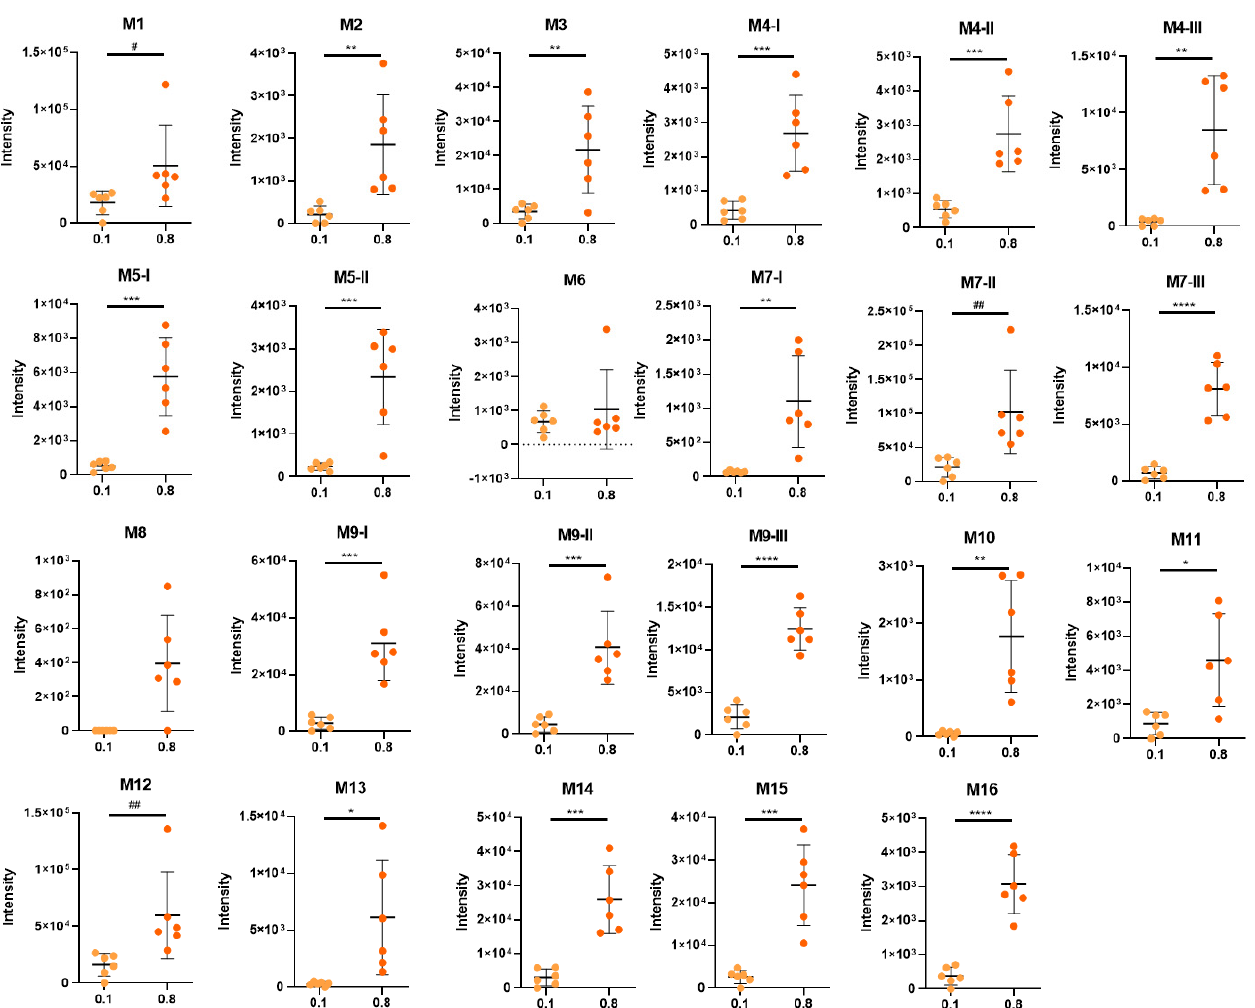
Figure 3. Intensity of metabolites identified in the urine of animals supplemented with 0.1% and 0.8% D-limonene expressed in mean ± SD. * Represent statistical differences using t -test (* p < 0.05; ** p < 0.01; *** p < 0.001; **** p < 0.0001). # Represent statistical differences using Wilcox test ( # p < 0.05; ## p < 0.01).